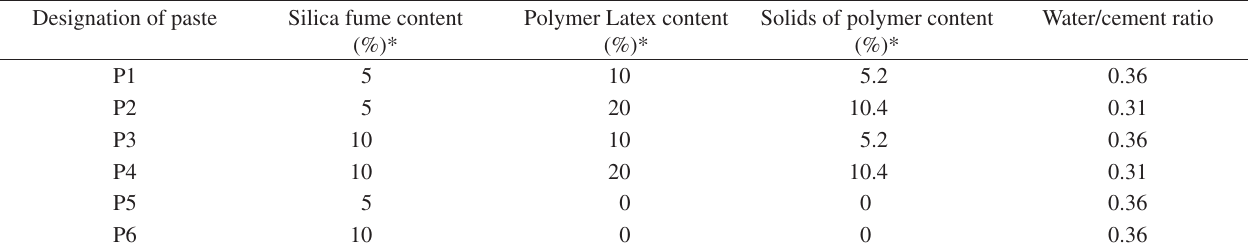
Table 4. Mixture proportion of the mortars.